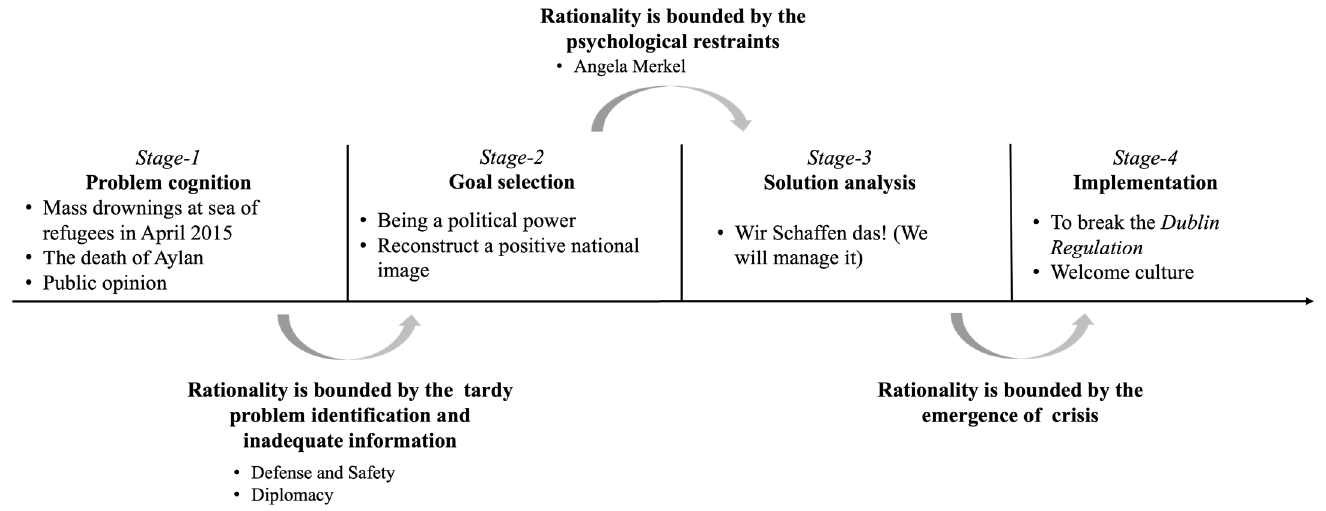
Figure 3. Diagram of the first shift in the refugee policy of Germany. Flow chart made by authors.